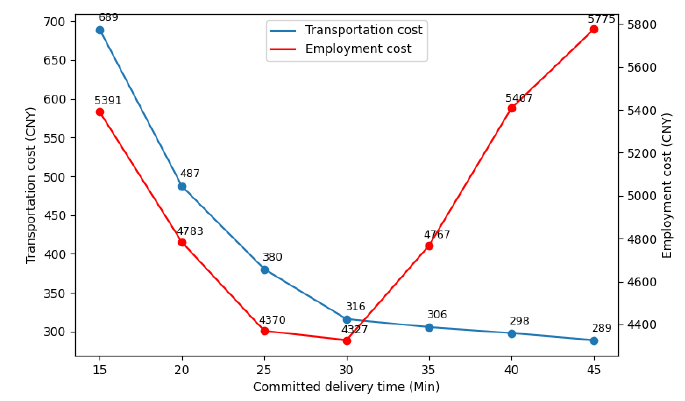
Fig. 11. The impact of the committed delivery time on transportation and employment